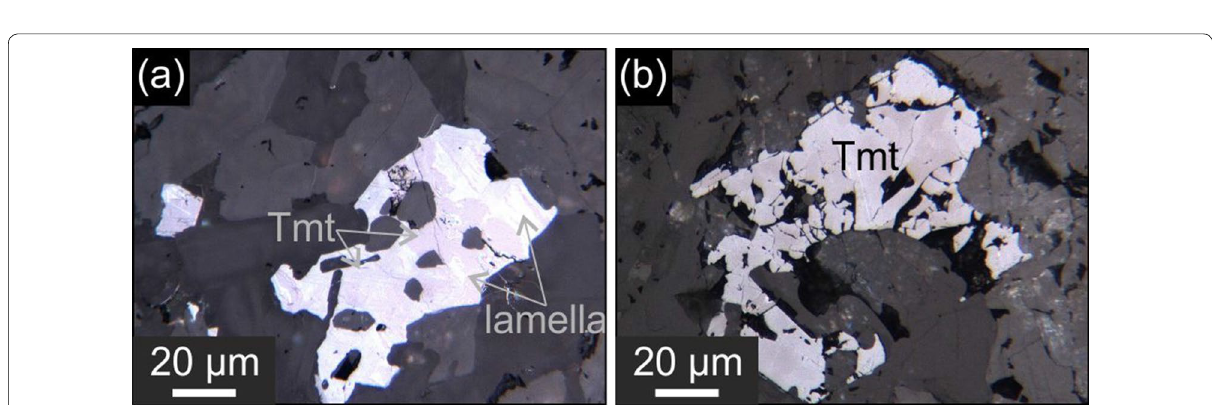
Fig. 3 Reflected light photomicrographs present a oxyexsolved Tmt grains with Ti‑rich lamellae and b an optically homogeneous titanomagnetite (Tmt)